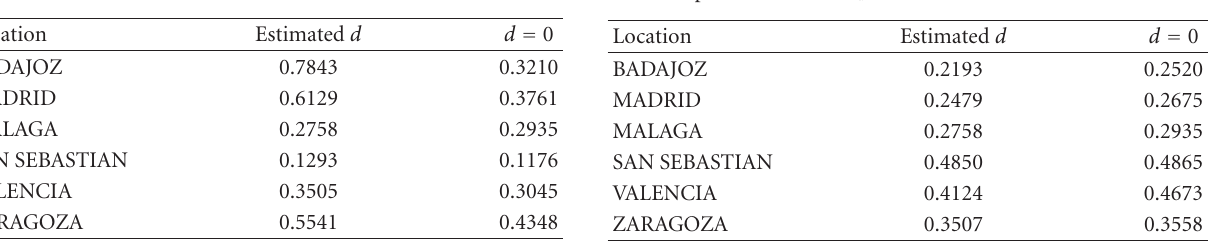
Table 5: Annual increase in the temperatures (in 0.1 ◦ C). Series: T max .